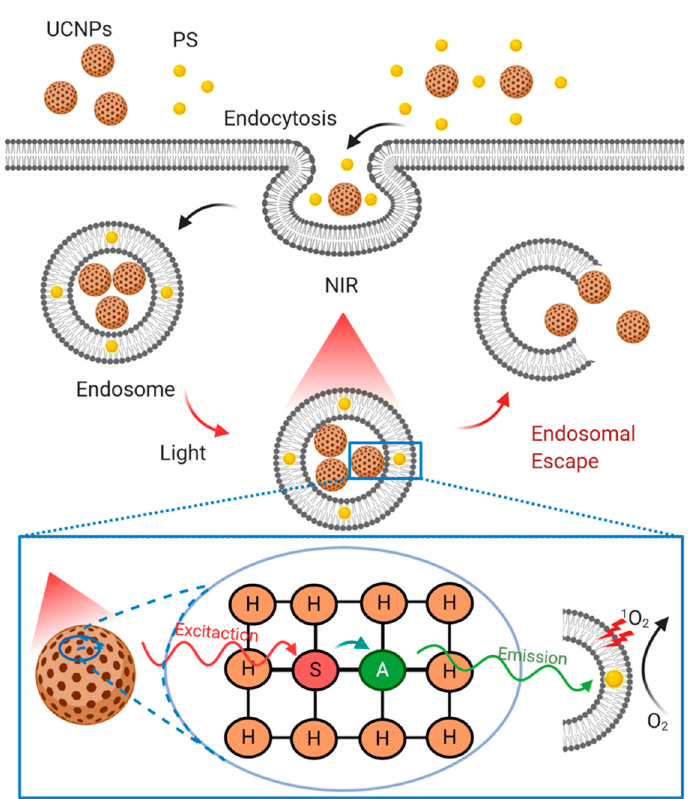
Figure 5. Schematic of the photochemical internalization followed by UCNPs to escape from endo- somal entrapment. UCNPs and photosensitizers (PS) are taken up by the cell via endocytosis and co-localized with endosomes. PS intercalate within endosomal membranes due to their amphiphilic properties. After NIR irradiation, the energy absorbed by sensitizer ions (S) is transferred to activator ions (A), then emitting radiation, either in the UV or Vis range. Next, the PS absorbs the activator ion’s energy and transfers it to molecular oxygen to produce highly toxic singlet oxygen, which causes severe damage to the endosomal membrane due to its oxidative effects on amino acids (e.g., tryptophan, cysteine, histidine, methionine, and phenylalanine), unsaturated fatty acids and cholesterol. Ultimately, membrane disruption is achieved, and UCNPs escape from endosomes. H: host matrix. This schematic was based on Rueda-Gensini et al. [73]. Created with BioRender.com.